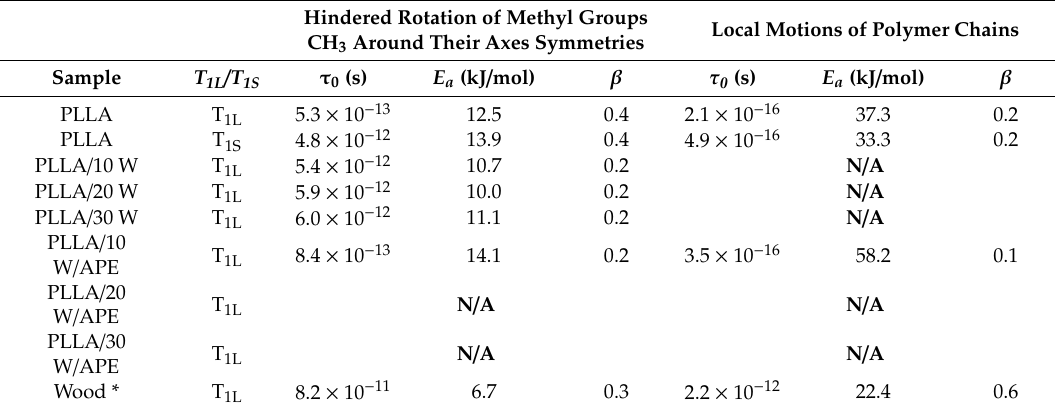
Table 3. Motional parameters obtained for PLLA formulations from fitting the theoretical relaxation curves to experimental data. The values of uncertainty of the estimated parameters were lower than 10%. T 1L is the long and T 1S is short relaxation time, τ 0 is the pre-exponential factor, E a is the activation energy of molecular motions, and β is the distribution width of correlation